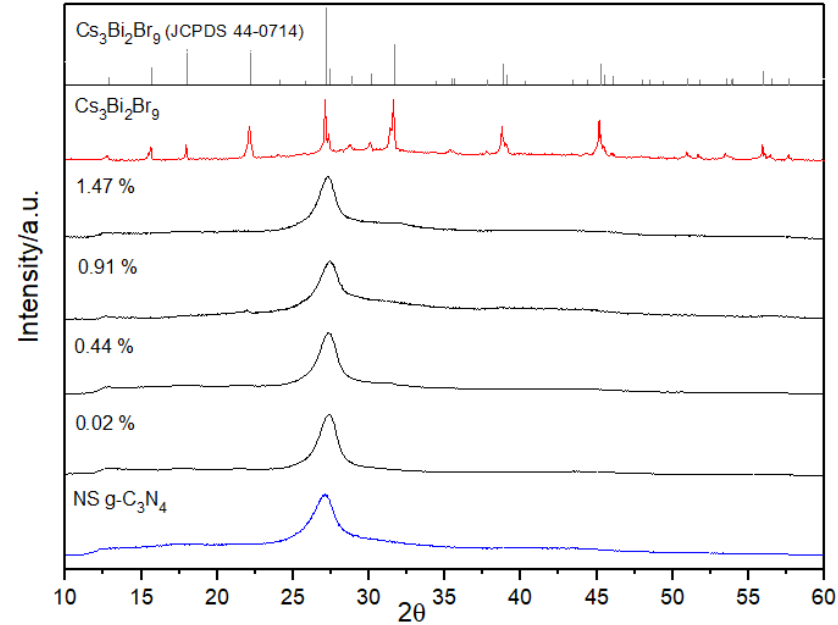
Figure 1. X-ray diffraction patterns of the g-C 3 N 4 nanosheets, the Cs 3 Bi 2 Br 9 nanocrystals, Cs 3 Bi 2 Br 9 NCs/g-C 3 N 4 NSs composites produced at different percentages of perovskite loading (wt.%) and the reference pattern of the Cs 3 Bi 2 Br 9 .